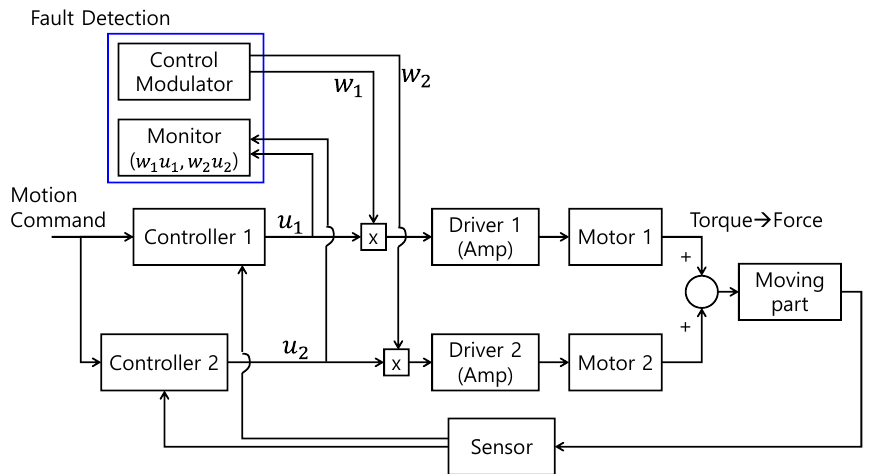
Figure 7. Proposed fault detection method for two motors.